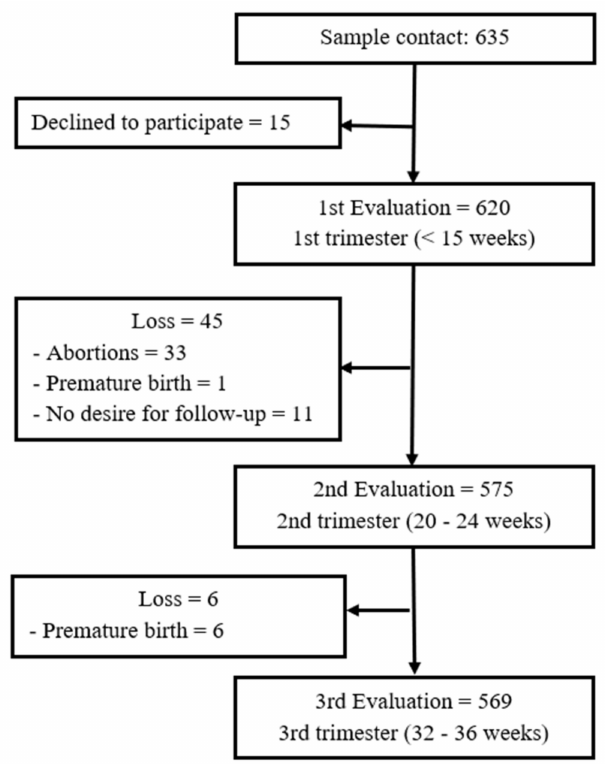
Figure 1. Flow diagram of recruitment and progress through the